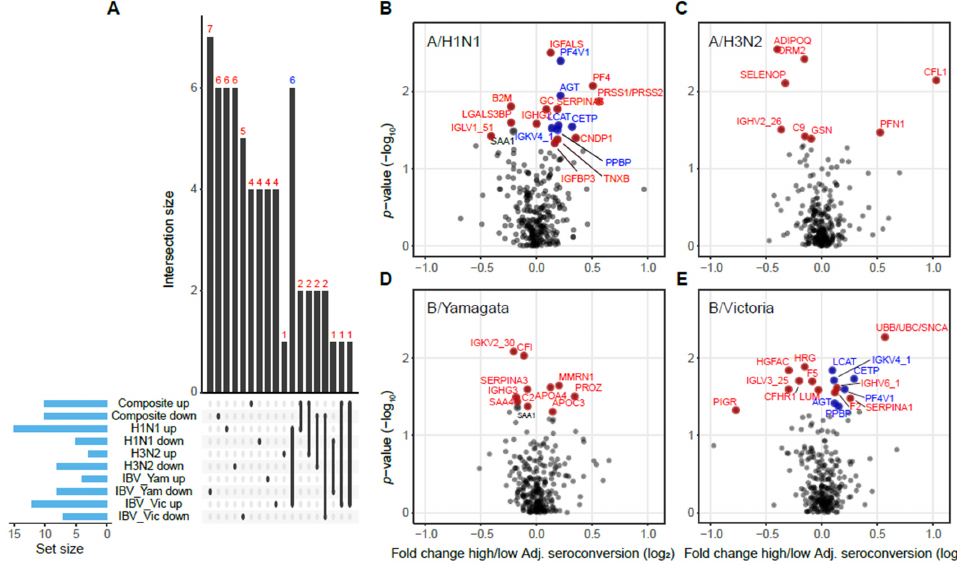
Figure 4. Strain-specific signatures of adjusted seroconversion. ( A ) Overlap between up- and down- regulated genes in participants with the highest and lowest composite and strain-specific adjusted seroconversion. Genes up-regulated in participants with high adjusted seroconversion against A/H1N1 and against B/Victoria have the largest overlap and are labeled in blue. ( B – E ) The volcano plots show the strain-specific fold changes in protein levels between participants with high and low adjusted seroconversion. Genes labeled in red and blue colors correspond to the sets shown in panel ( A ). Adj. seroconversion, adjusted seroconversion.